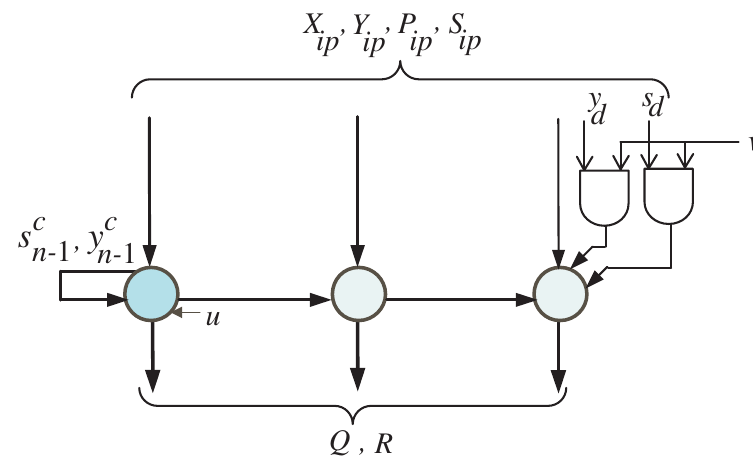
Figure 4. SISO postprocessing array for k =